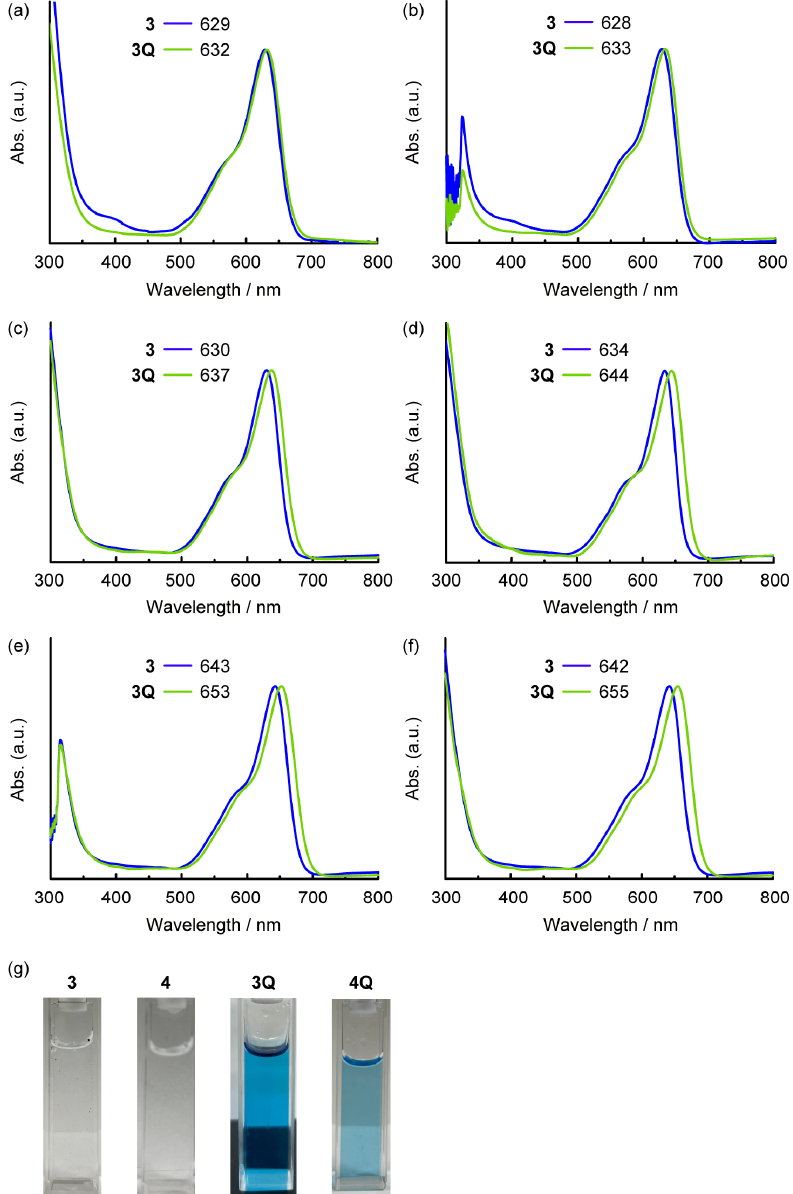
Figure 3. UV-vis-NIR absorption spectra of 3 (blue) and 3Q (light green) in ( a ) DMSO, ( b ) acetone, ( c ) THF, ( d ) toluene, ( e ) o -DCB, and ( f ) CHCl 3 solutions ( c = ca. 1.0 × 10 − 5 M). ( g ) Photographs of DMSO/Phosphate-buffered saline (PBS) buffer = 1:1 ( v / v ) solutions of 3 , 4 , 3Q , and 4Q ( c = approximately 1.0 × 10 − 5 M). Compounds 3 and 4 were insoluble under this condition.